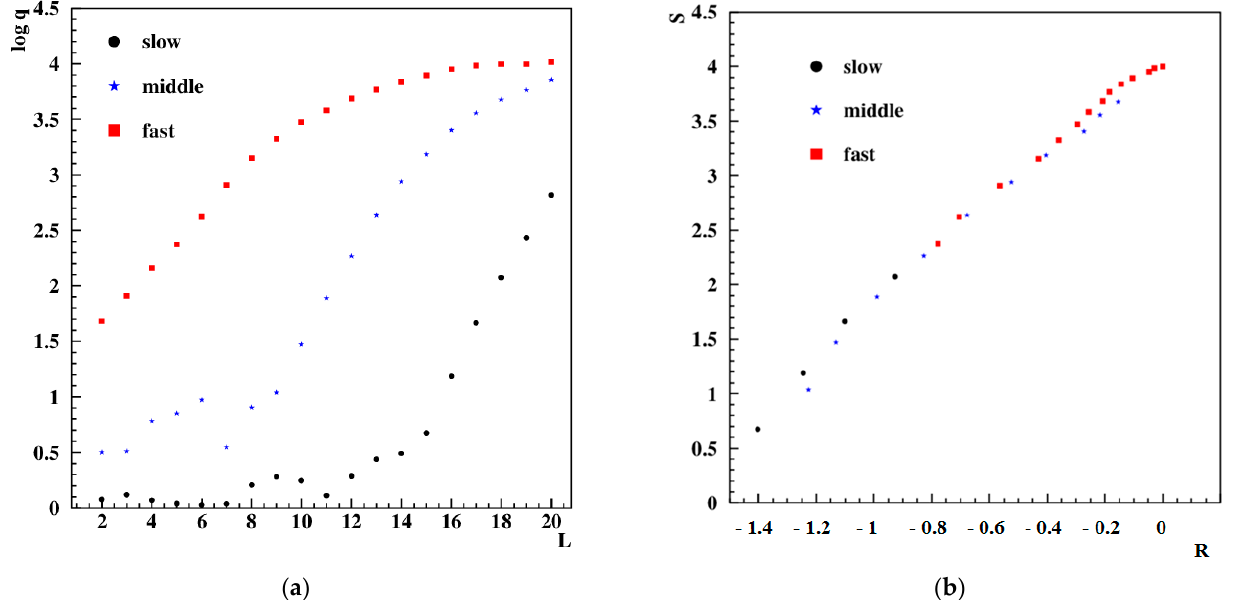
Figure 2. ( a ) Cascade curves for three showers of 10 TeV protons with fast, medium, and slow character of the development of the cascade process; ( b ) The size–rate curves for the same showers.